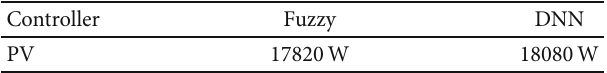
(b) Comparative analyses of MPPT controller for PV